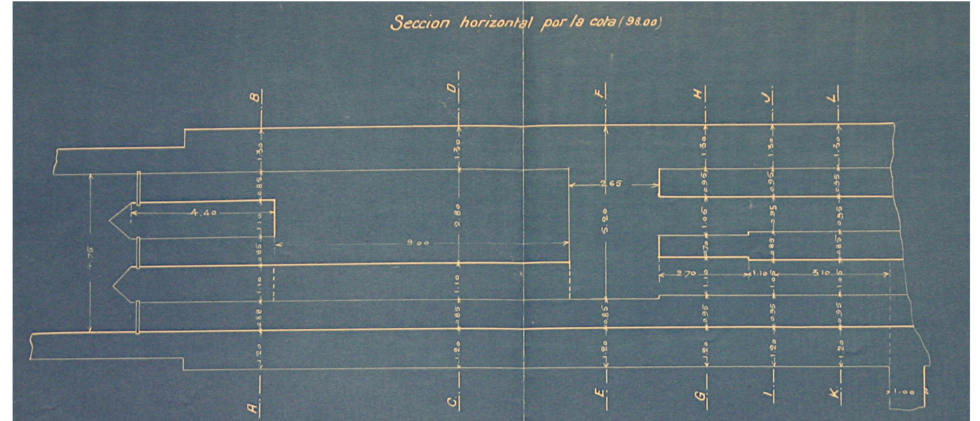
Figure 2. Dimensional data of hydroelectric power station project. Source: General Archive of the Duero Hydrographic Confederation, FACC, PCC, C-2177,